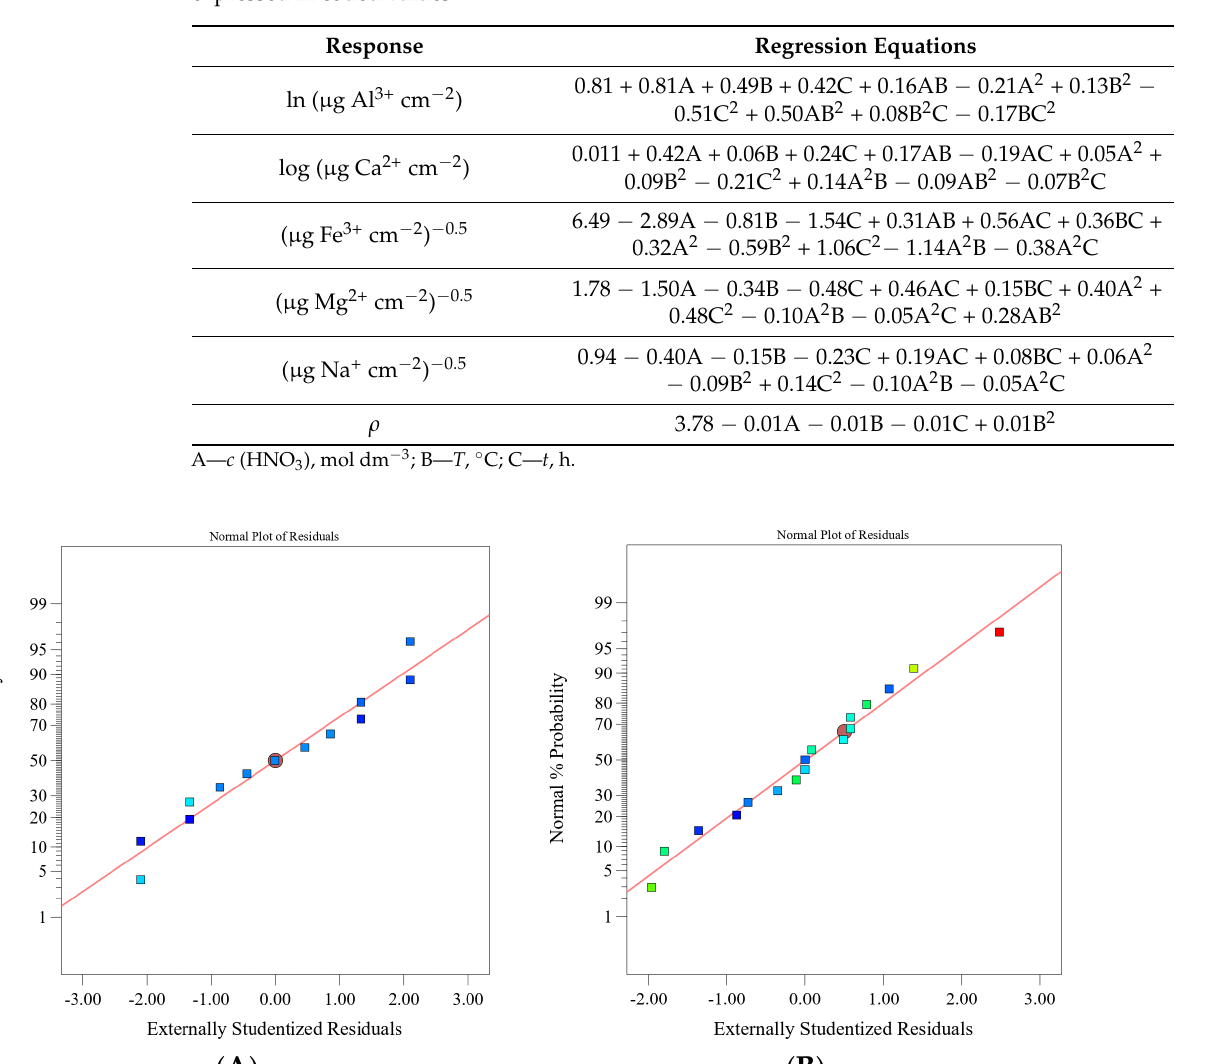
Table 7. Regression equations of the amount of eluted ions and the density of alumina ceramics expressed in coded values.